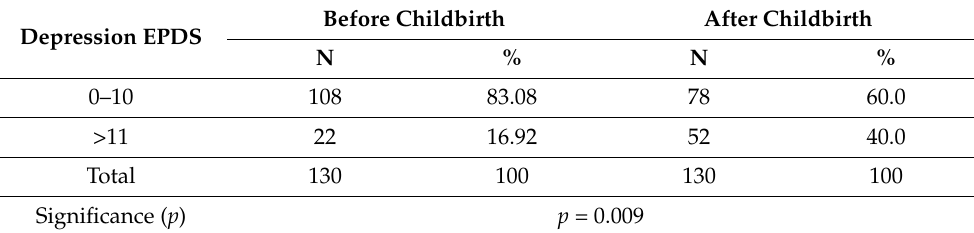
Figure 1. Level of prenatal and postnatal: depression ( a ) and anxiety ( b ) in the study group. (cid:3) —mean; (cid:3) —mean ± standard error; I—mean ± 1.96 standard error. Table 2. Level of prenatal and postnatal depression in the study